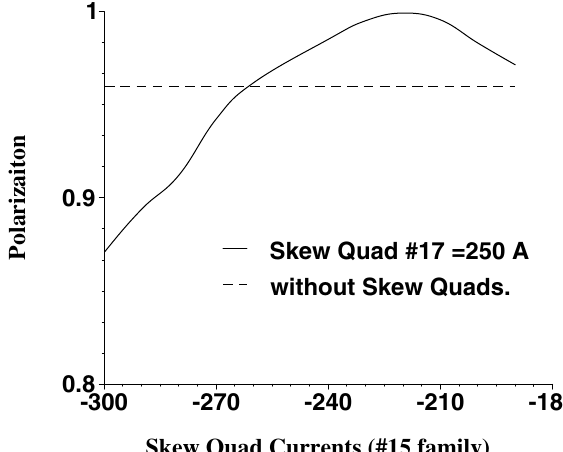
FIG. 8. Polarization after crossing the 12 (cid:5) (cid:28) with fixed normal mode tunes ( (cid:28) currents for hypothetical skew quadrupoles in the 15th straight sections. The 17th skew quadrupole family was fixed at 250 A. (The wiggle in the curve is due to an occasional failure of the MAD program to find the set tunes.) The dashed line indicates base polarization without any skew quadrupoles operating.